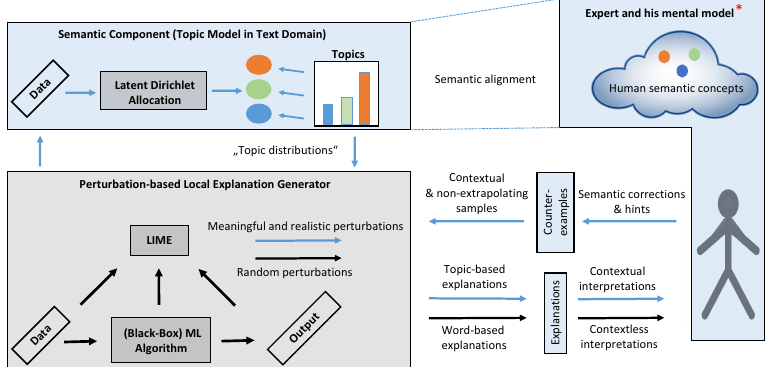
Figure 1. Architecture for constructive and contextual interactions. * In this work, we simulate the expert for efficient evaluation purposes using a conceptual Gold Standard as explained in Sections 3.3 and